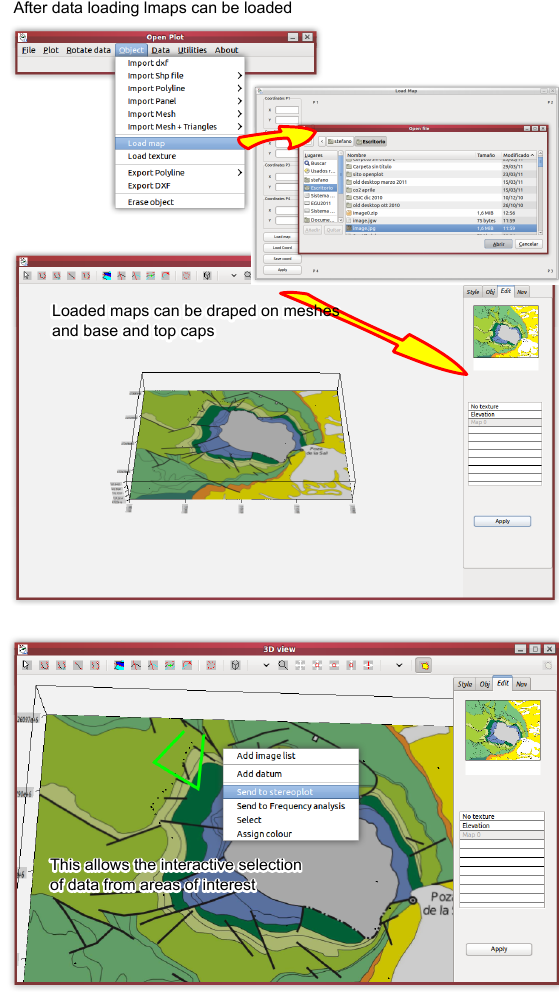
Fig. 7. Procedure for loading maps, draping them on objects in the 3-D view window, and selecting data from an area of